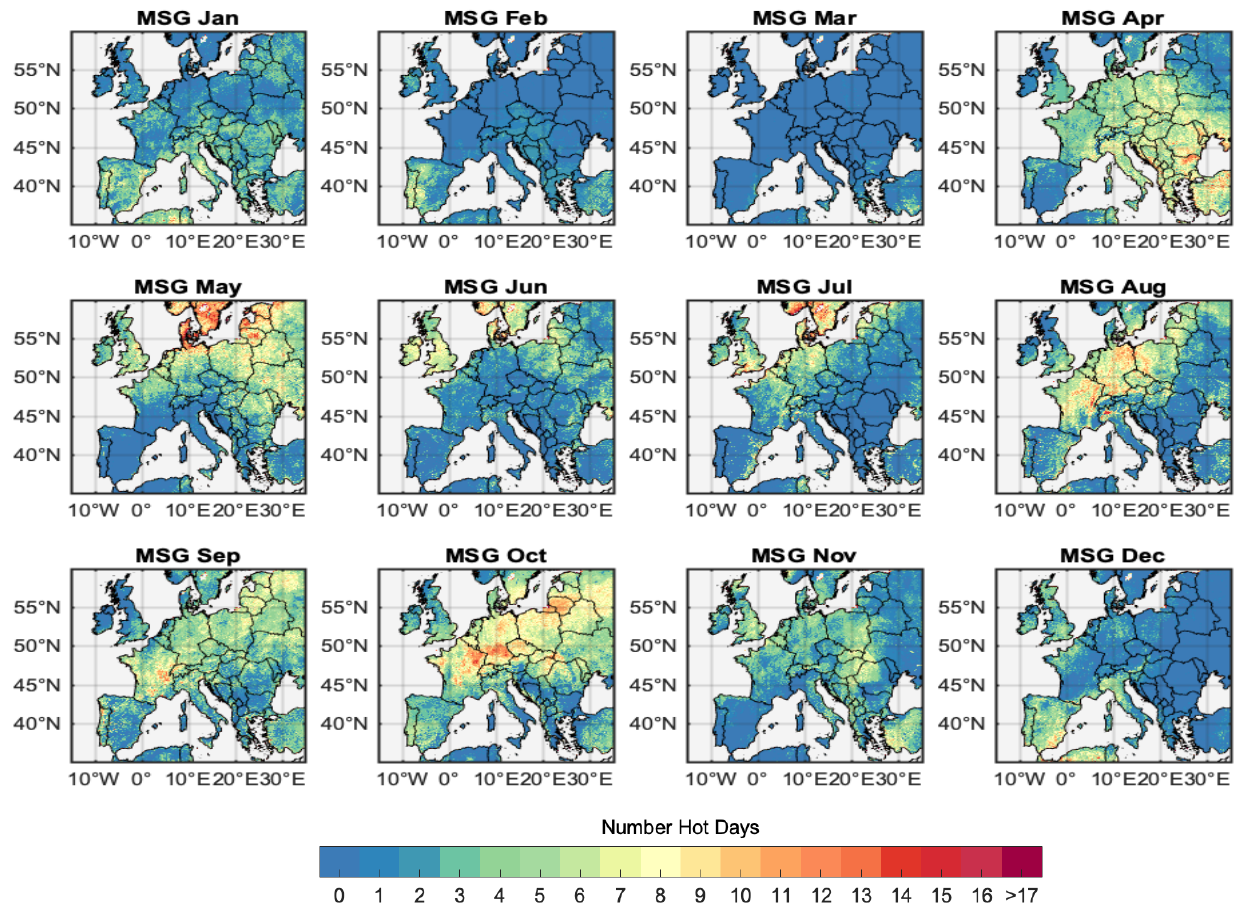
Figure 5. Monthly number of hot days (NHD) during 2018 over Europe, with respect to the period from 2004 – 2019.